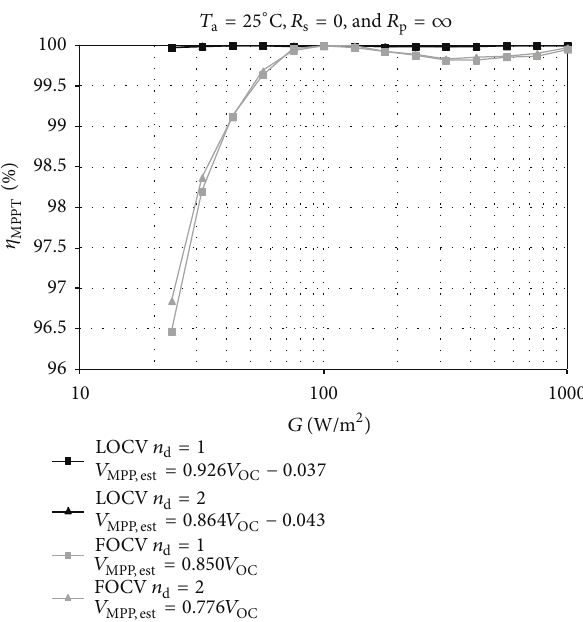
= and with 𝑛 a d Figure 5: Computed 𝜂 versus 𝐺 by using the FOCV and LOCV MPPT methods for a single PV cell at different values of 𝑛 = 0 , and 𝑅 = ∞ 25 ∘ C, 𝑅 s p